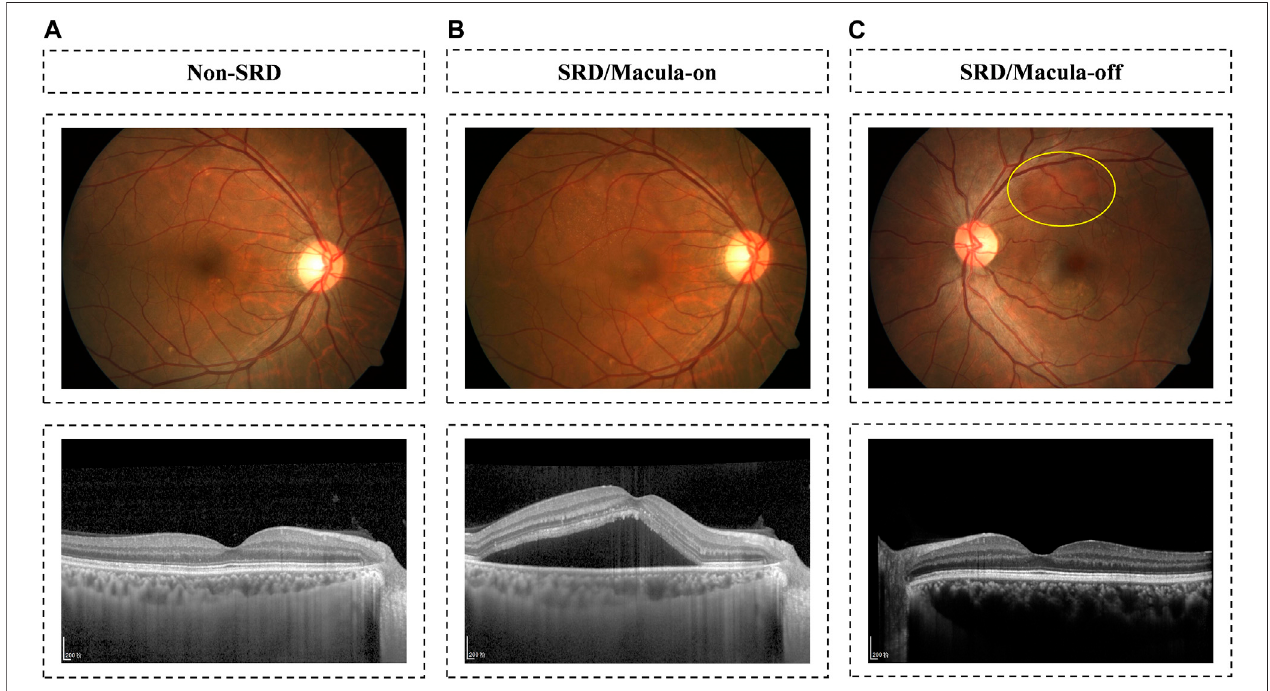
FIGURE 1 | Fundus image examples with OCT-veri fi ed CSC. Examples of three CSC states: non-SRD on the panel (A) ; macula-on SRD on the panel (B) ; and macula-off SRD in the panel (C) .